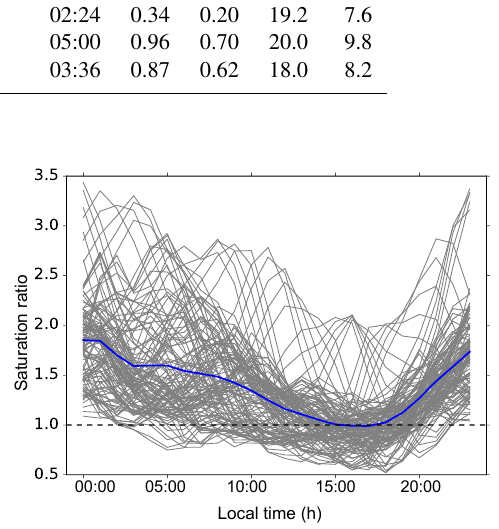
Figure 2. Hourly mean values of the saturation ratio /p ∞ ) in the latitude band 67–71 ◦ N for July 2009 ( S (cid:117) p H 2 O at a fixed altitude of 82.7km (mean PMC height) as a function of local time. Grey lines show individual days and the blue line their